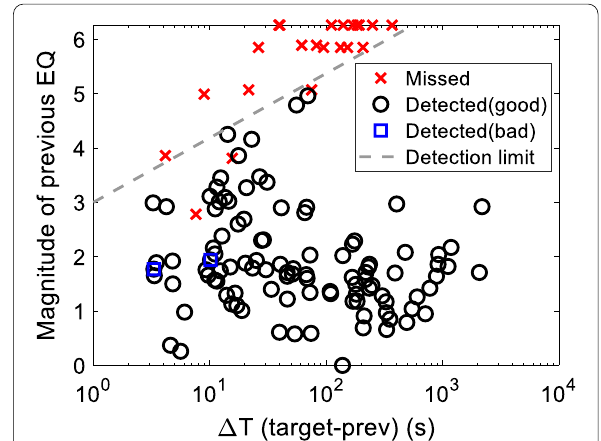
Fig. 10 Relationship between the time interval and magnitude of the previous earthquake for the 127 earthquakes with an observed SI 4. “Detected(good)” and “Detected(bad)” indicate the earthquakes ≥ with location errors ≦ 30 km or > 30 km,